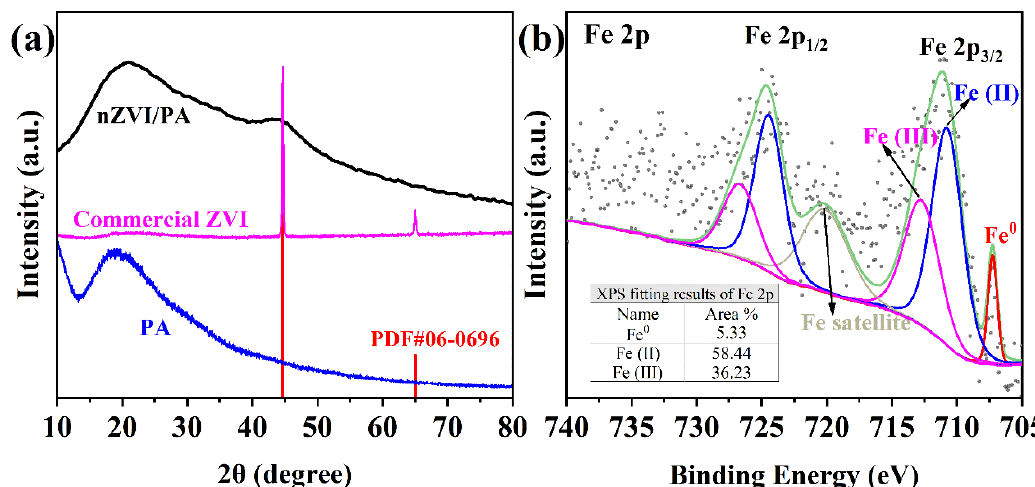
Figure 2. XRD patterns of PA, commercial ZVI, and nZVI/PA composites ( a ), and high-resolution XPS spectra of nZVI/PA composites ( b ).